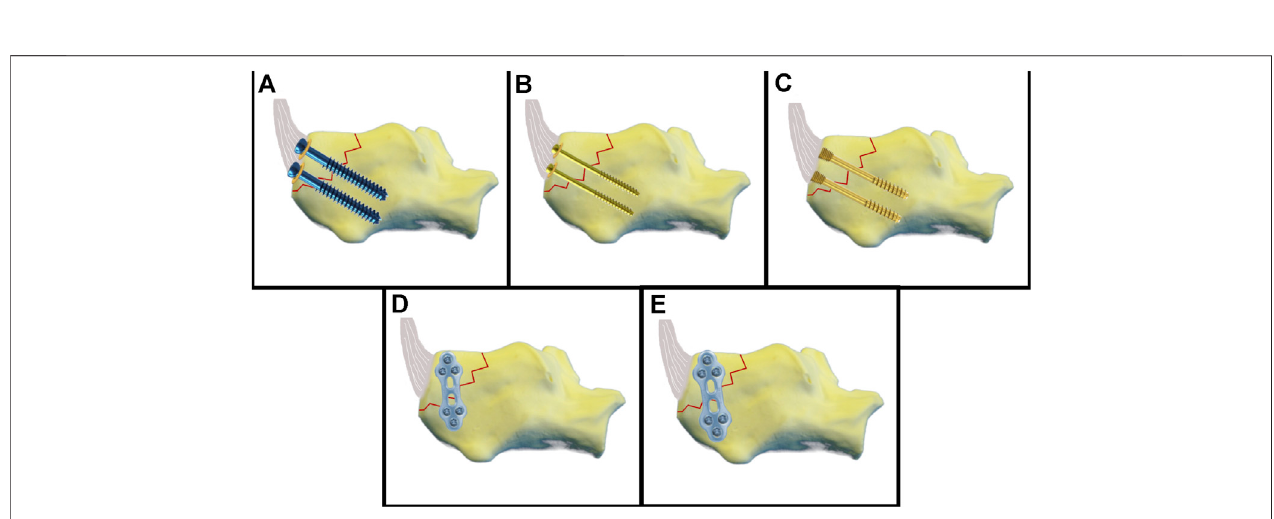
FIGURE 2 | Schematic illustration of the fi xation techniques. (A) 6.5-mm partial threaded cannulated screw. (B) 4.0-mm partial threaded cannulated screw. (C) 5.0 headless cannulated compression screw. (D) 2.3-mm plate fi xation. (E) 2.8-mm plate fi xation.